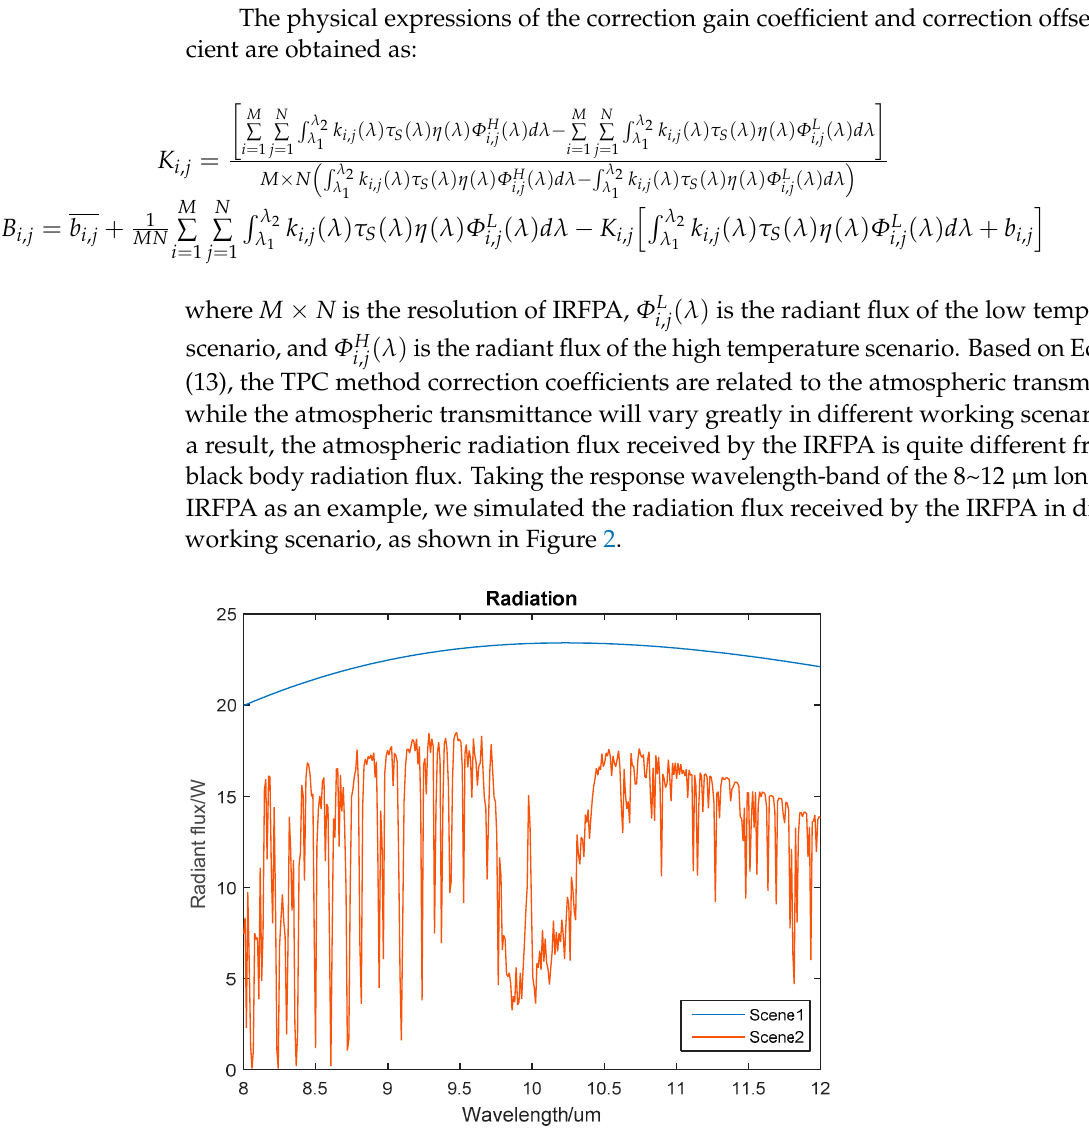
Figure 2. The effect of atmospheric transmittance on radiation: Working scene 1 is the black body calibration of the laboratory environment; working scene 2 is the sky scene where the ground observation sky height is 50 km and the target distance is 55 km.